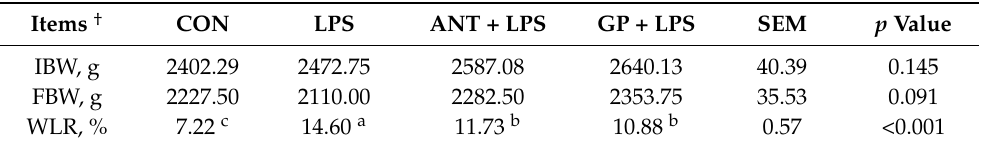
Table 1. Effects of dietary garlic powder inclusion on the body weight in broiler challenged with